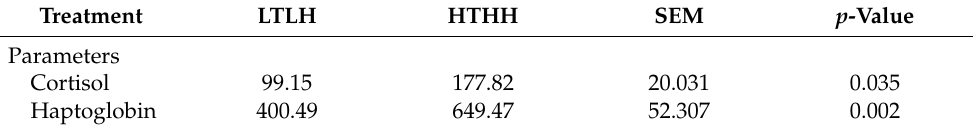
Table 7. Blood cortisol and haptoglobin in dairy cows exposed to two distinct environmental